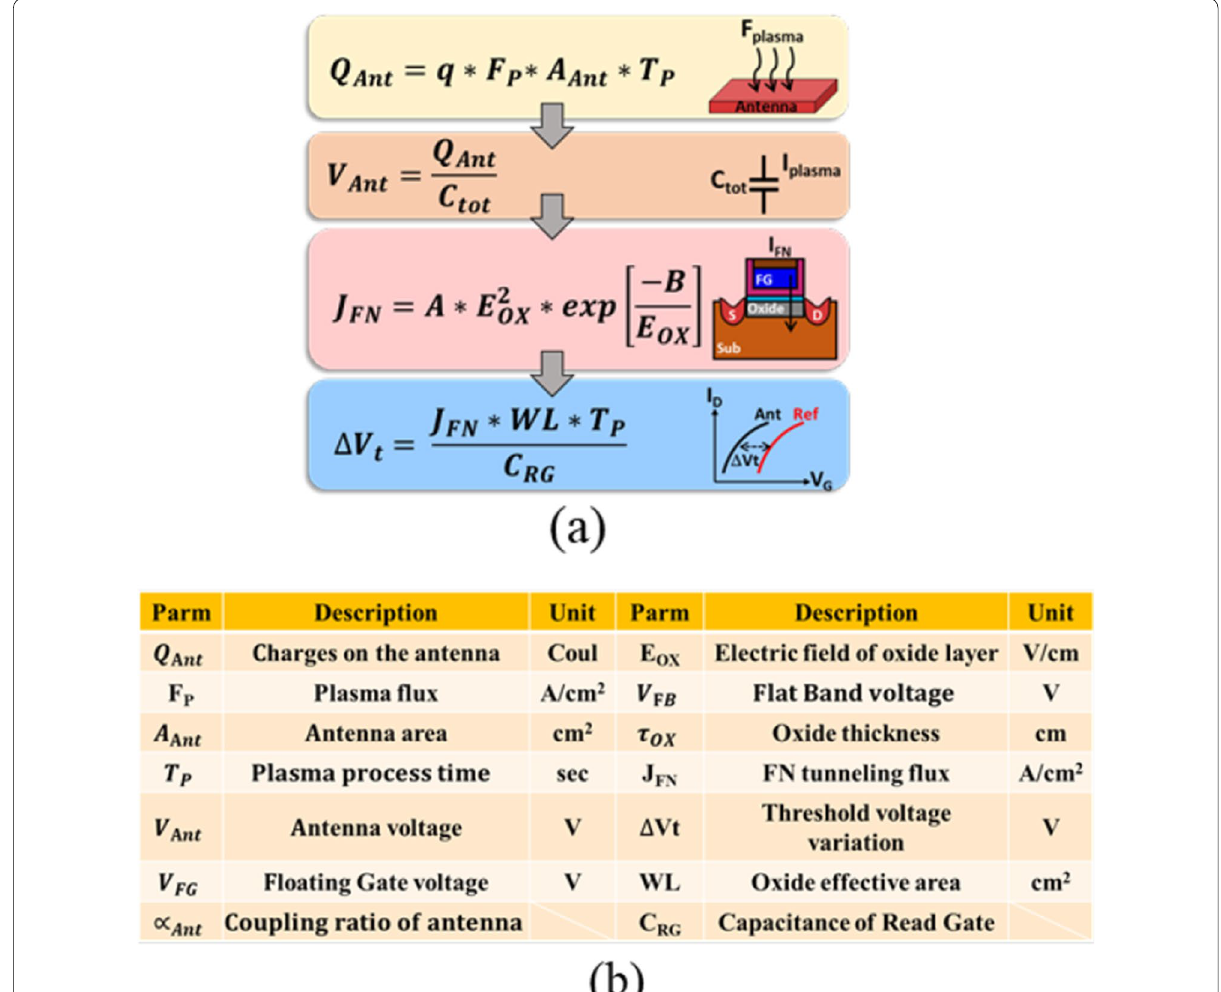
Fig. 3 a The flow chart from plasma charges ( Q Ant ) collected on the antenna to shift V t . Based on the FN tunneling model, Δ V t can be calculated. b The list of parameters with its definitions